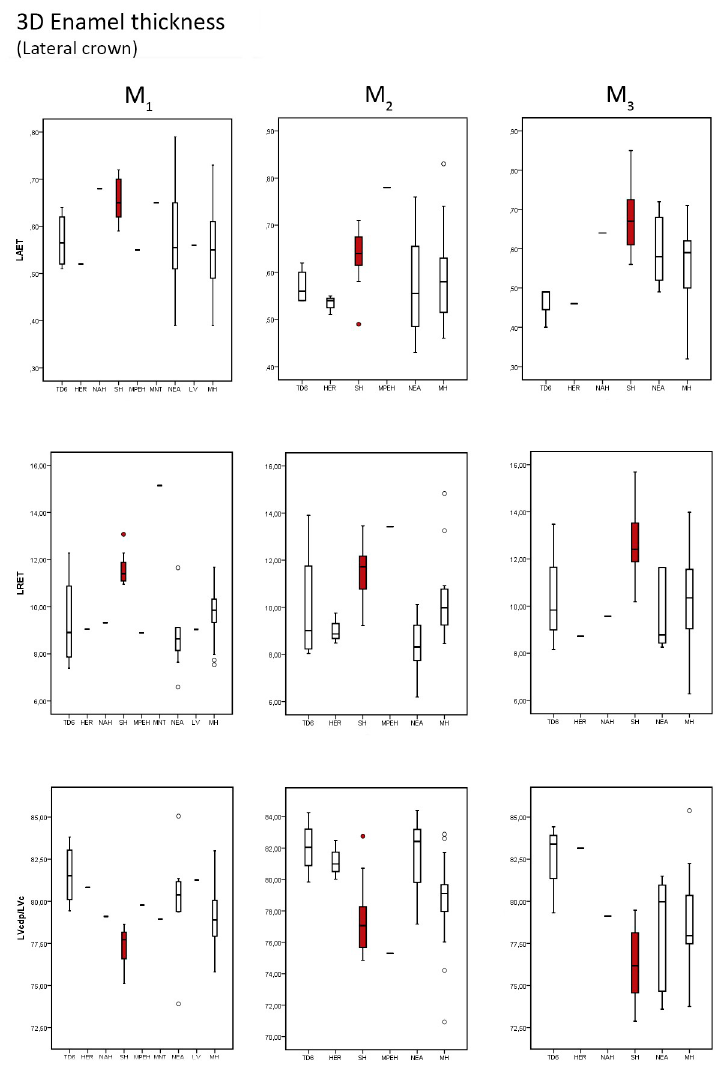
Fig 8. Box plots of the 3D, lateral enamel, values. 3D values depicting the lateral average enamel thickness (3D LAET), lateral relative enamel thickness (3D LRET) and the percentage of dentine and pulp in the lateral aspect of the crown (LVcdp/LVc), in the mandibular molars of the SH and the comparative